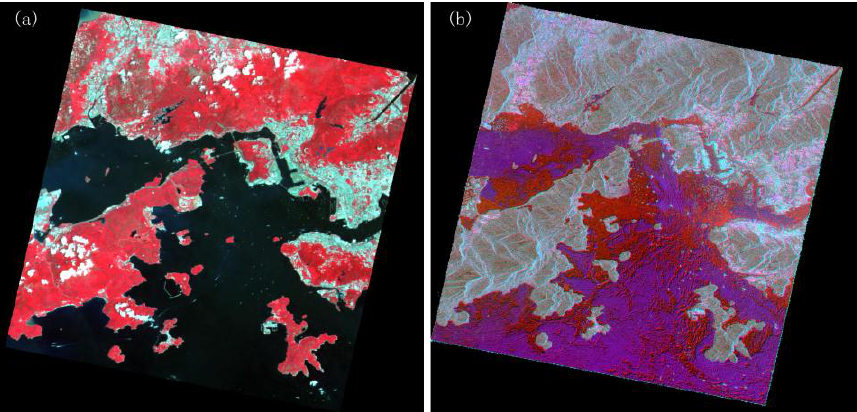
Figure 1. HJ-1 CCD and Radarsat-2 image of study area, (a) HJ-1 CCD (RGB normalization false color composition), (b)